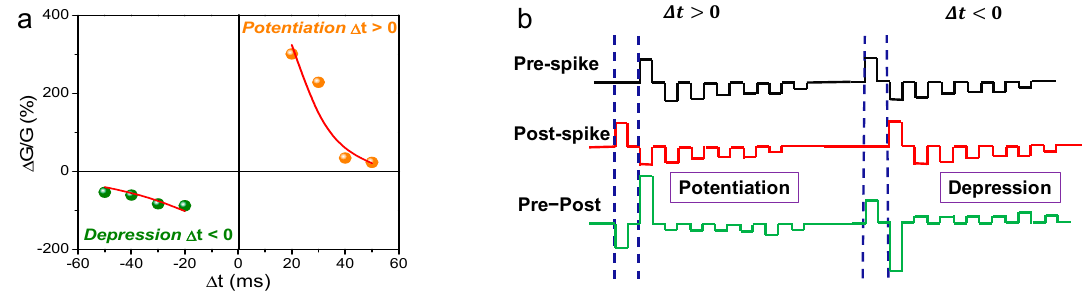
Figure 5. ( a ) Spike-timing-dependent plasticity (STDP)-like curve of Ni / SiN / BN / n ++ -Si device. ( b ) Prespike and postspike pulse scheme to implement STDP.